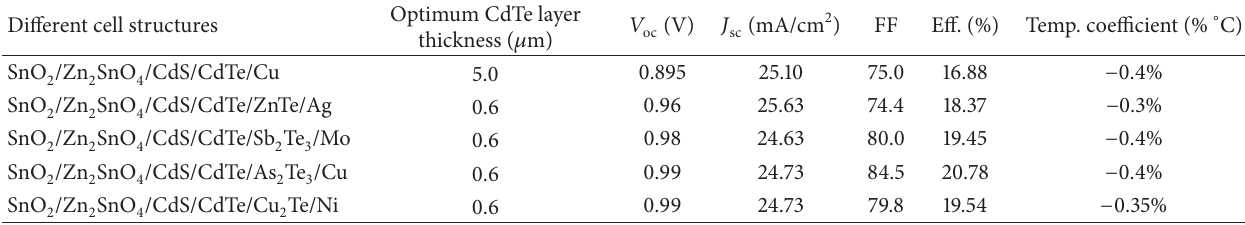
Table 2: Output parameters of different cells with BSF for maximum efficiency.